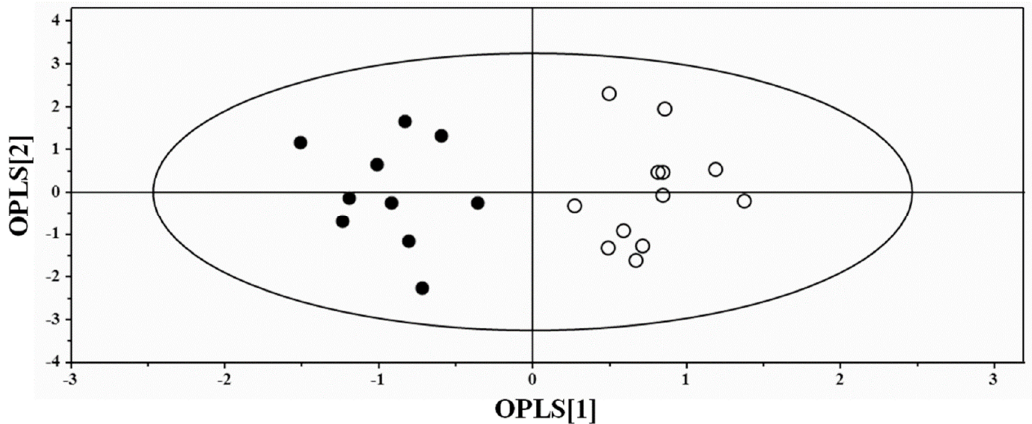
Figure 2. OPLS-DA scores plot of 1 H-NMR spectra of urine samples: C (full circle) and CRC (open circle) subjects. The OPLS-DA model was performed using one predictive and one orthogonal component and is described by R2X, R2Y, and Q2 values of 0.328, 0.957, and 0.539, respectively.